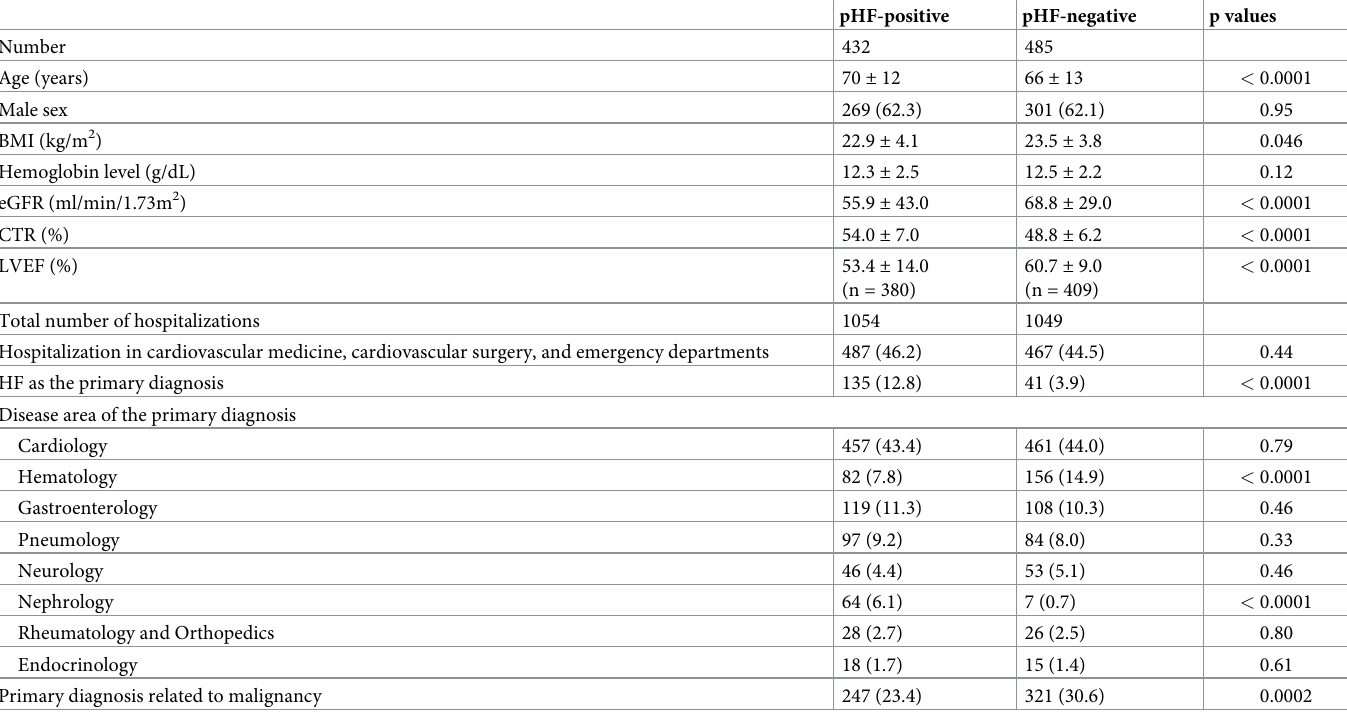
Table 1. Baseline information of studied patients and